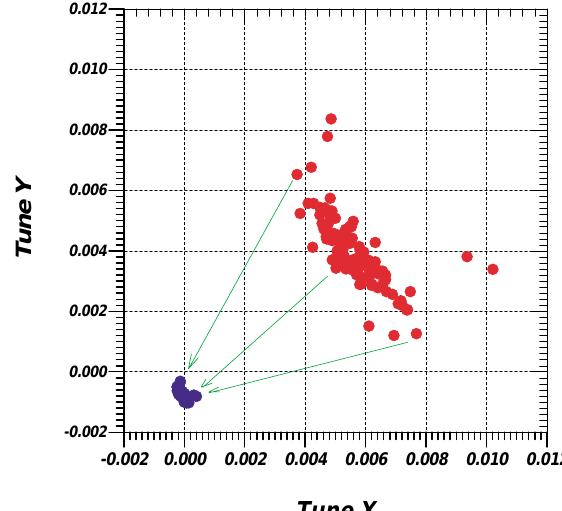
FIG. 5. (Color) Resulting ¯ p bunch tune shifts (core particles only) with 10% error of the compensation.